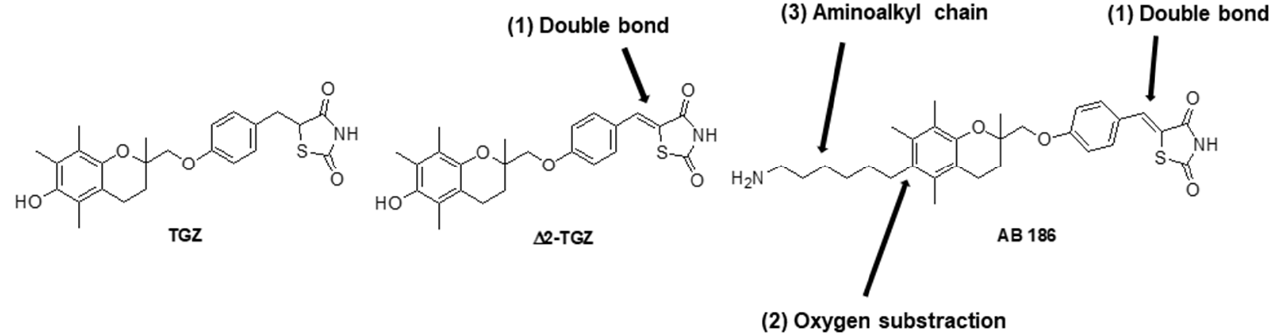
Figure 1. Structures of TGZ, ∆ 2-TGZ and AB186 compounds. ∆ 2-TGZ and AB186 are derived from the original TGZ and both of them possess a double bond (1) adjoining the terminal thiazolidine-2, 4-dione ring. AB186 also presents a deoxygenation of the chromane heterocycle (2) and a hydrophobic moiety (3).